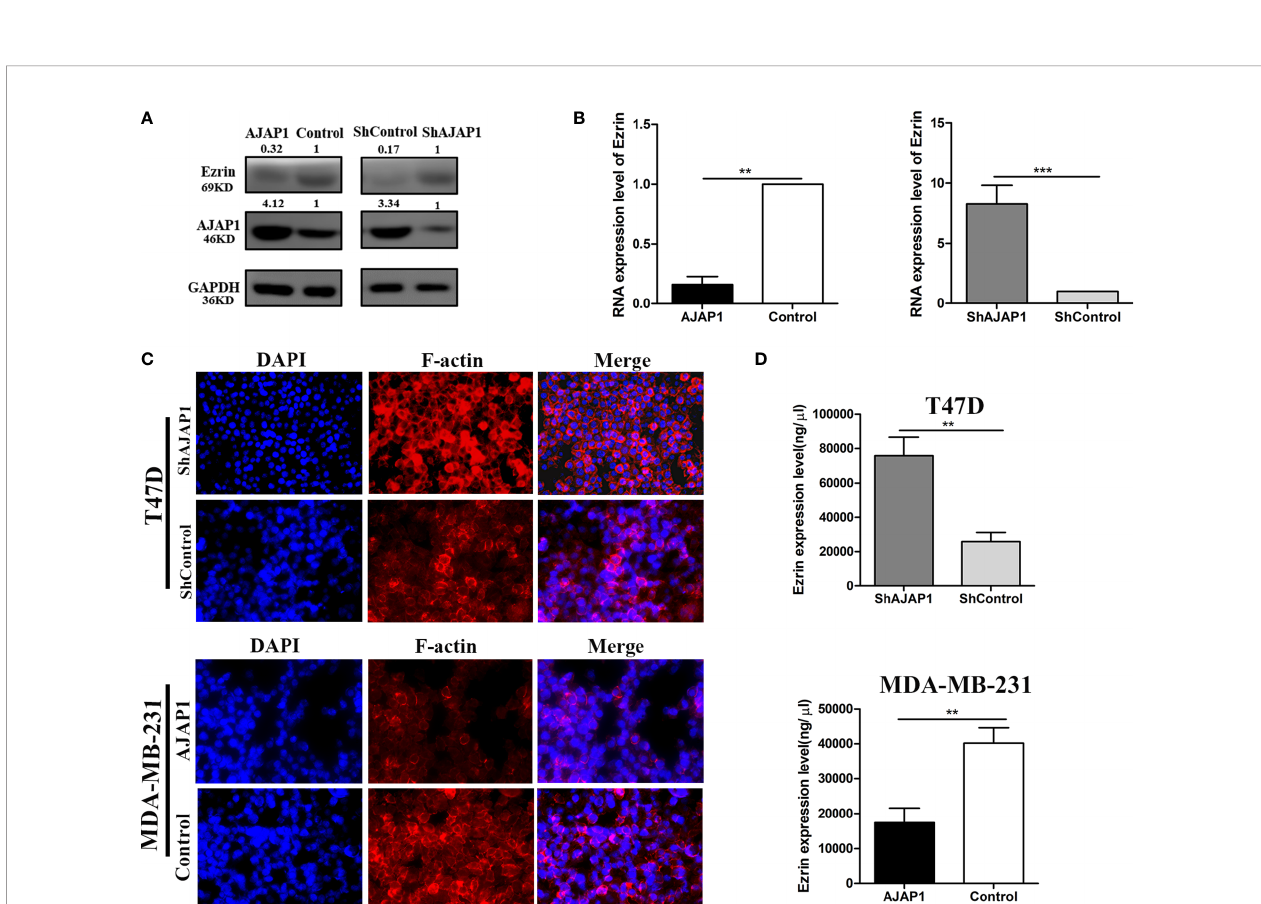
FIGURE 5 | AJAP1 inhibits cytoskeleton formation by reducing Ezrin expression. (A) Western blot results of Ezrin expression in AJAP1-overexpressed MDA-MB-231 cells and AJAP1-silenced T47D cells. (B) qRT-PCR results of Ezrin expression in AJAP1 overexpressed MDA-MB-231 cells and AJAP1-silenced T47D cells. (C) Fluorescent staining of F-actin by phalloidin in AJAP1 depletion T47D cells and AJAP1 overexpressed MDA-MB-231 cells. (D) The Ezrin level changes in different expression of AJAP1 stable cell lines by ELISA. Data were shown as mean ± SD. Each experiment was conducted at least three times ** p < 0.01, *** p < 0.001.